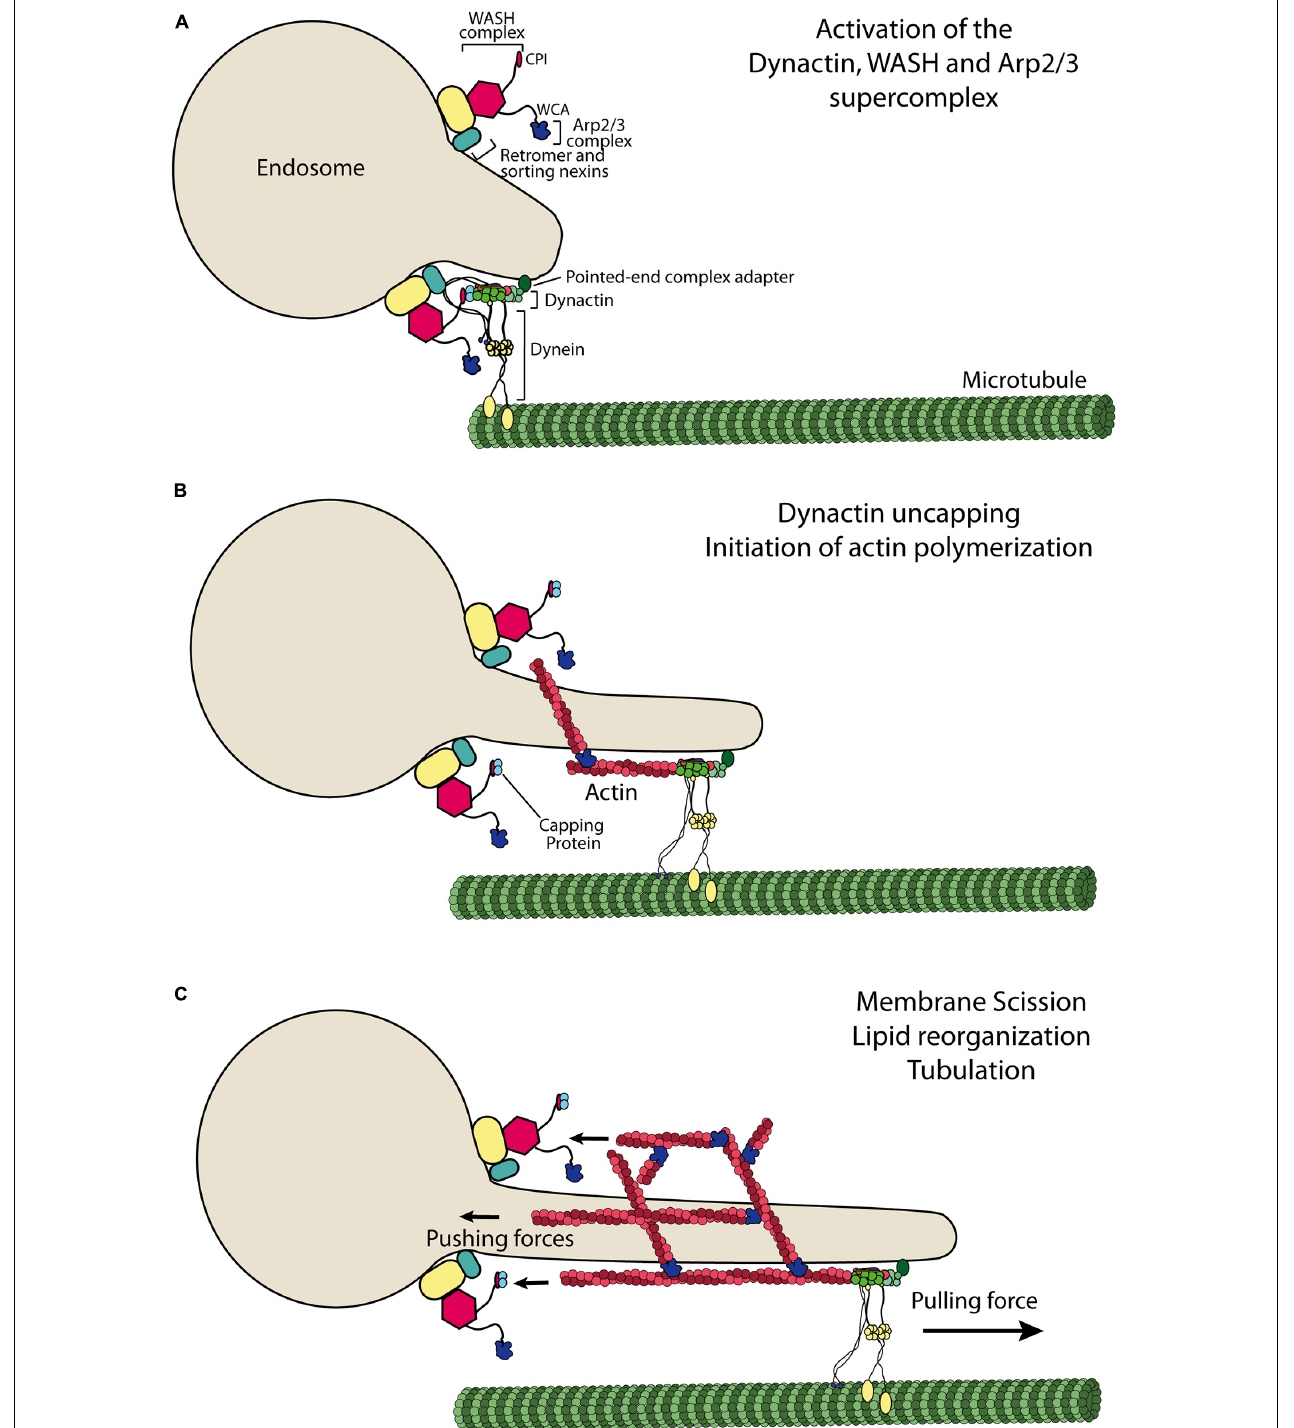
FIGURE 2 | Model of WASH-dependent generation of endosomal branched actin. (A) Dynactin is an essential adaptor for dynein-mediated transport. Dynactin interacts with the WASH complex, which uncaps its actin-like minifilament through its CPI motif. (B) Uncapped dynactin elongates an actin filament, which can then serve as a substrate for Arp2/3 mediated branching induced by its WCA motif. (C) The actin-like minifilament of dynactin is embedded in the branched actin network and thus undergoes a retrograde flow. The membrane tube is elongated by the pulling force of dynein, whereas WASH-Arp2/3 at the neck of the membrane tube pushes against the bulk of the endosome. These opposing forces are likely to stretch the membrane and promote its scission. WASH dependent branched actin networks were also reported to regulate the organization of lipidic microdomains and endosomal tubulation.